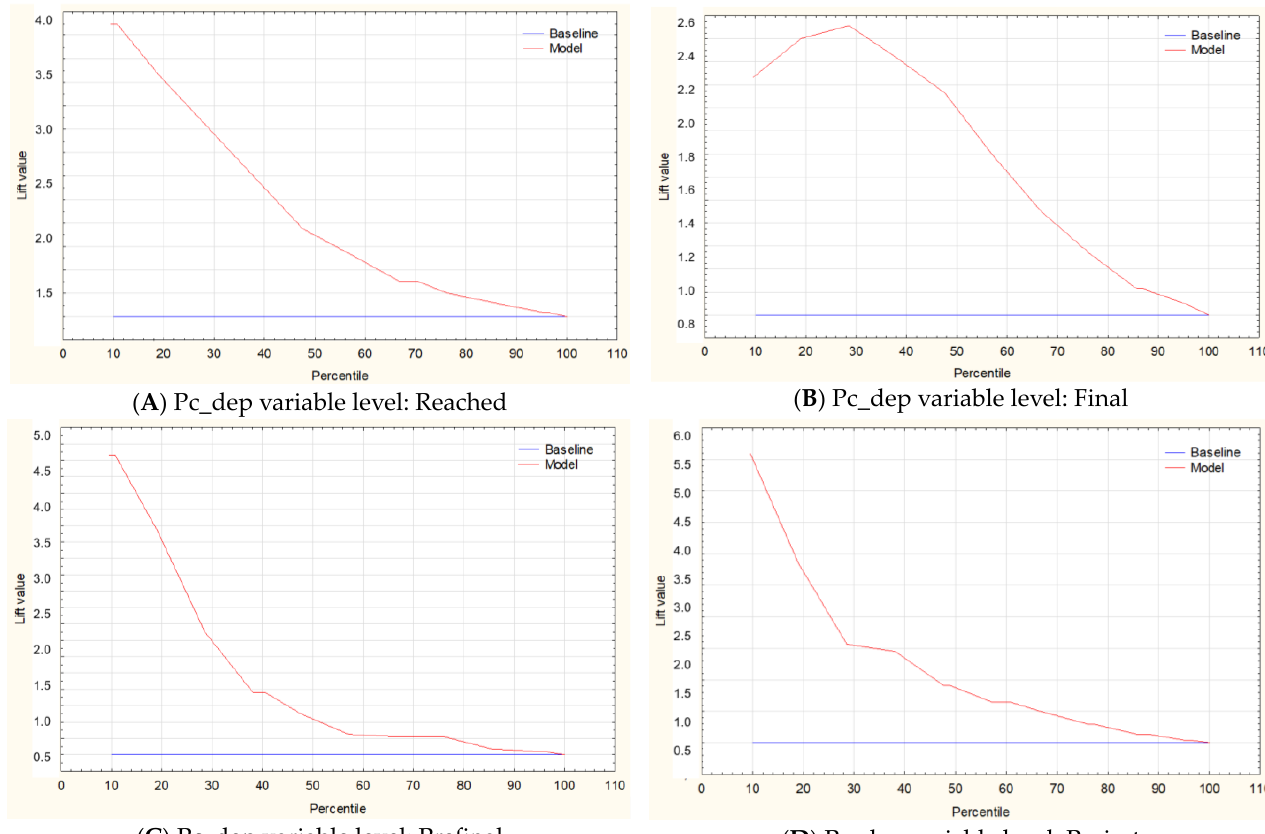
Figure 3. Cumulative lift diagrams for estimating the utility of the random forest model by the level of the categorical dependent variable Pc_dep.